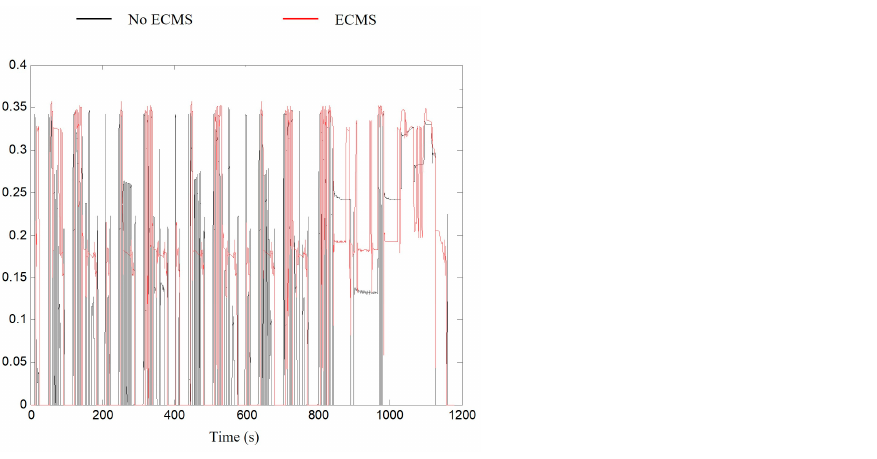
Figure 14. Comparison of engine thermal efficiency in two power systems under NEDC conditions.